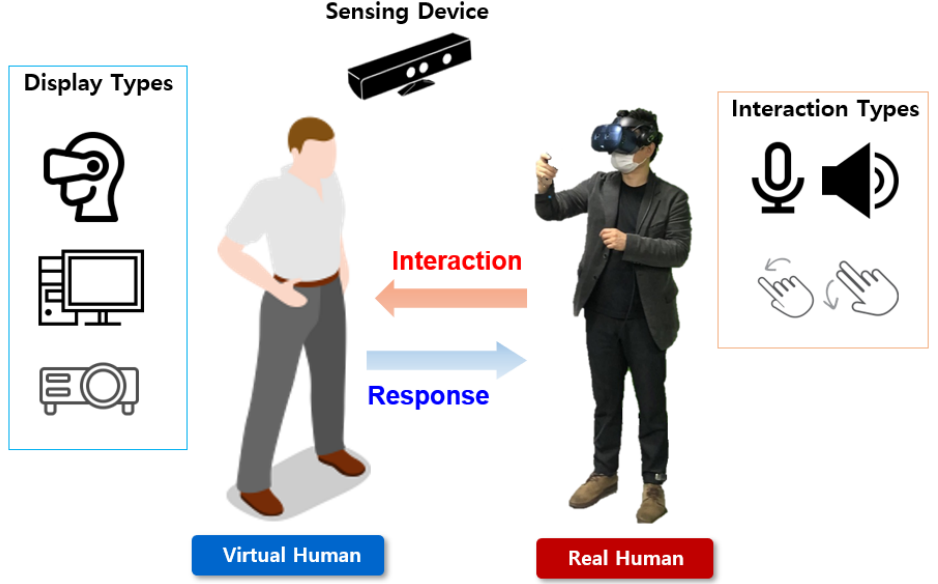
Figure 1. Display and interaction types with the virtual human and an example of a user’s interaction with a virtual human: our figure presents a scene in which a user’s gesture-based non-verbal interaction is given to the virtual human in an immersive 3D XR environment using a head-mounted display.